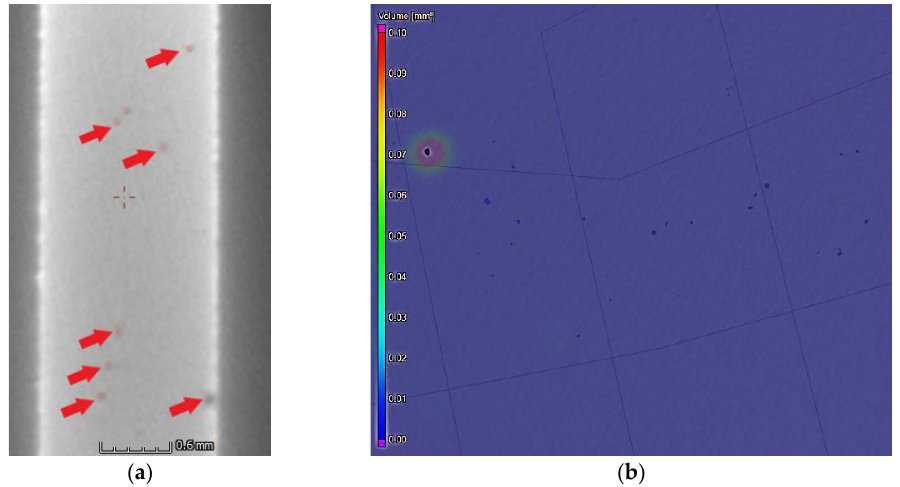
Figure 7. ( a ) Porosities identified in a CT image section of a CoCr – 304 specimen (top section); the pores are marked with red to show their location (size is lower than 0.10 mm). ( b ) Virtual reconstruction of CoCr area; some random porosities were recorded up to 0.1 mm 3 marked with blue.